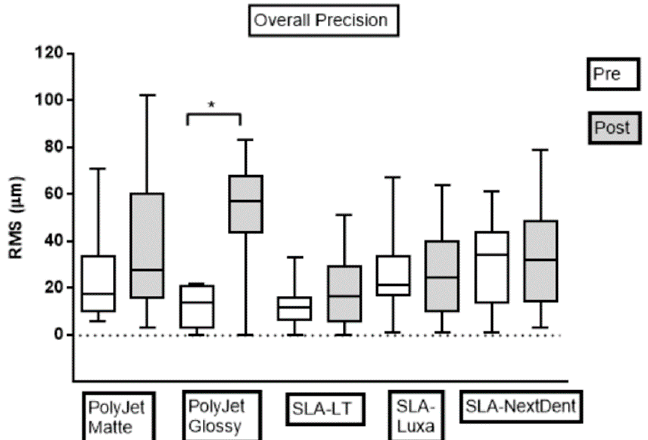
Figure 4. Boxplot demonstrating dimensional accuracy measurements (pre- and post-sterilization) reflecting overall precision RMS values in all groups. Pre, pre-sterilization; Post, post-sterilization; RMS, root mean square. The dotted line represents the CAD reference line.